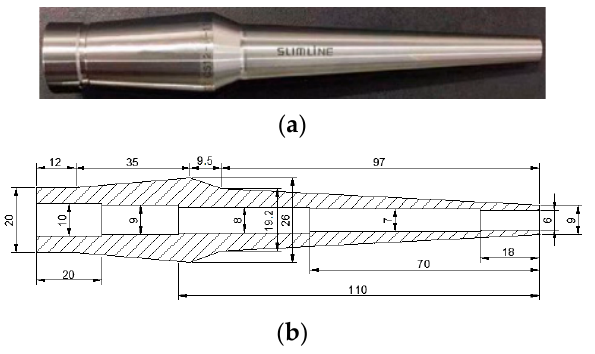
Figure 1. Shrink-fit holder. ( a ) Material object; ( b ) structural diagram.